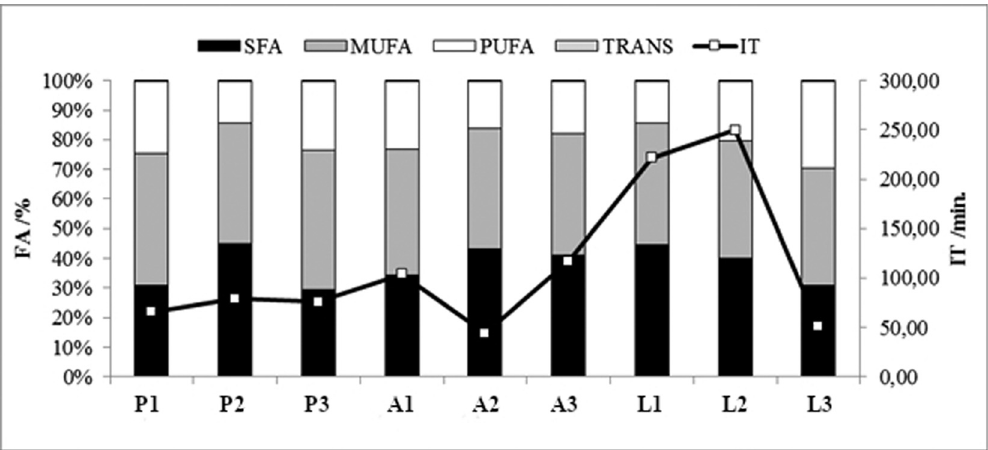
Figure 1: The composition of fat extracted from low - priced ( L1, L2 and L3 ) , fairly average - priced ( A1, A2 and A3 ) and premium - priced ( P1, P2 and P3 ) cat feeds. The percentage of speci fi c fatty acids ( FAs ) is indicated on the main y - axis ( left ) with black ( SFA ) , gray ( MUFA ) , white ( PUFA ) and light gray ( TRANS ) bars. IT ( points connected with a line ) is denoted on auxiliary axis ( right ) .